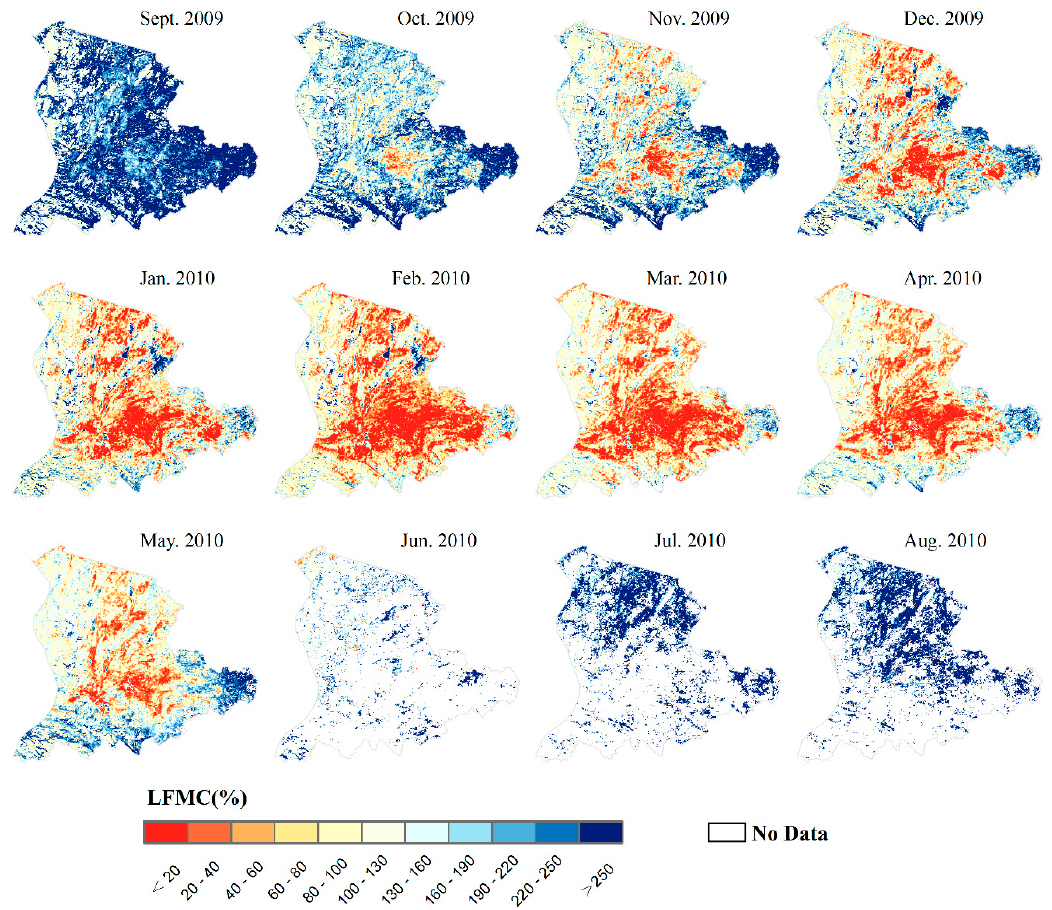
Figure 5. Multi-temporal mapping of monthly LFMC over southwest China throughout the 2009 / 2010 fire season.